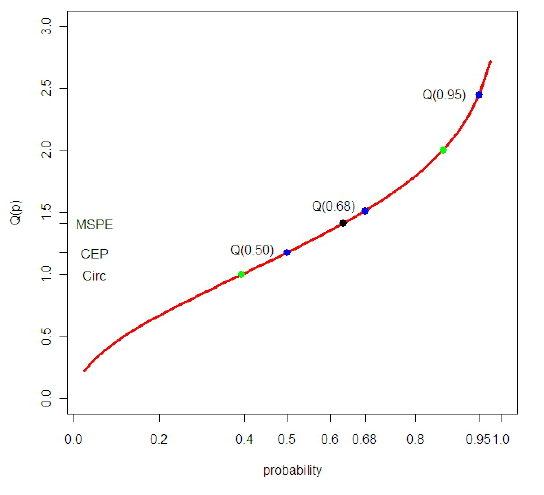
Figure 3. Horizontal accuracy measures and their